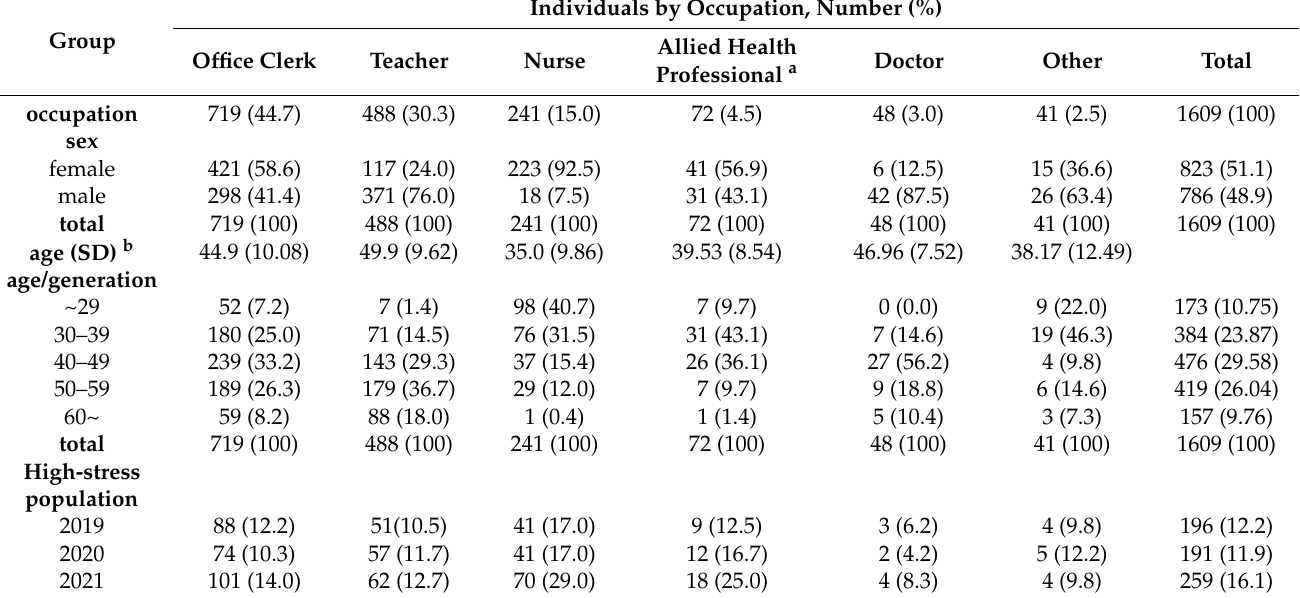
Table 1. Demographic Characteristics of university